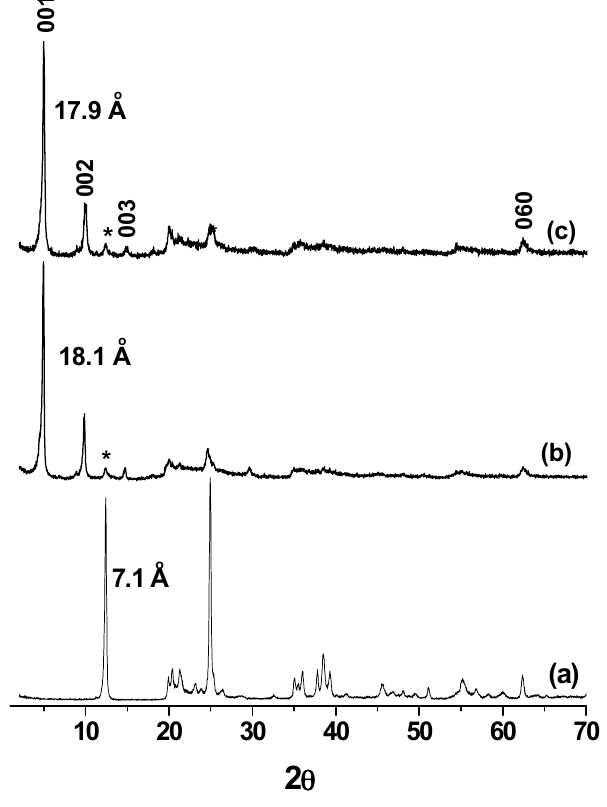
Figure 1. Powdered XRD patterns (diffractometer operating with Cu-K α radiation ( λ = 1.54056 Å)) of ( a ) kaolinite; ( b ) NI intercalated kaolinitewashed with isopropyl alcohol; and ( c ) after washing the product ( b ) in water. Kaolinite residual peaks are marked by *.